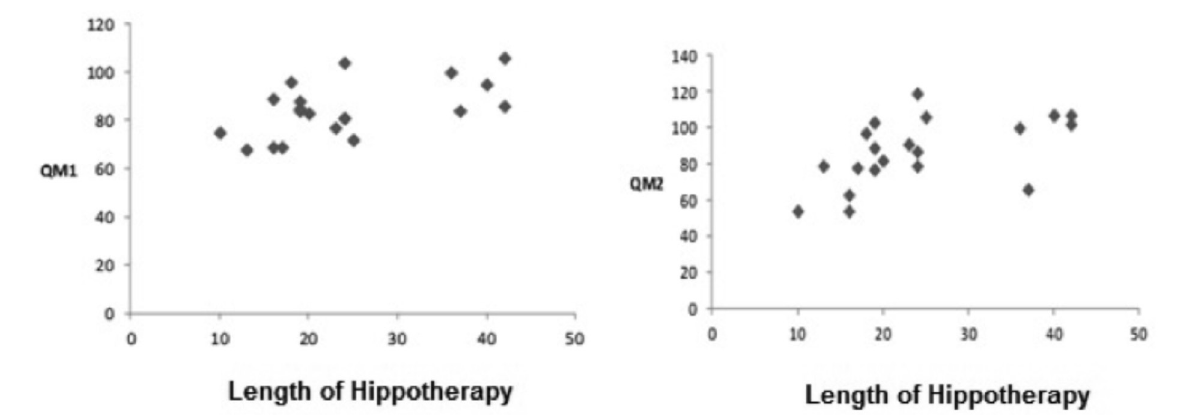
Figure 4 - Time (in months) of Hippotherapy and each Task of Koperkoordination Test furKinder (KTK) that presented significant correlation.